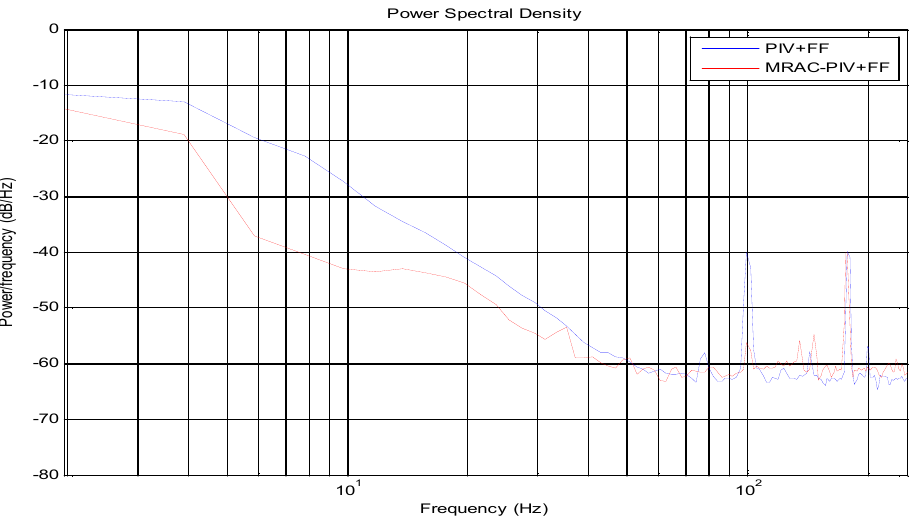
Figure 10. Power spectral density of PIV+FF and MRAC-PIV+FF.